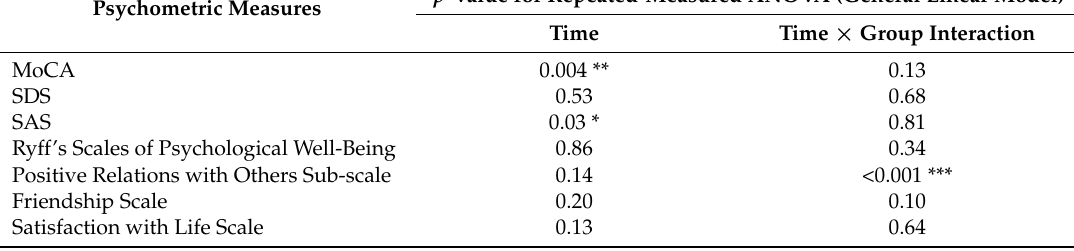
Table 4. Results from the analyses of psychometric measures at baseline, 3-months and 6-months post-intervention. Psychometric